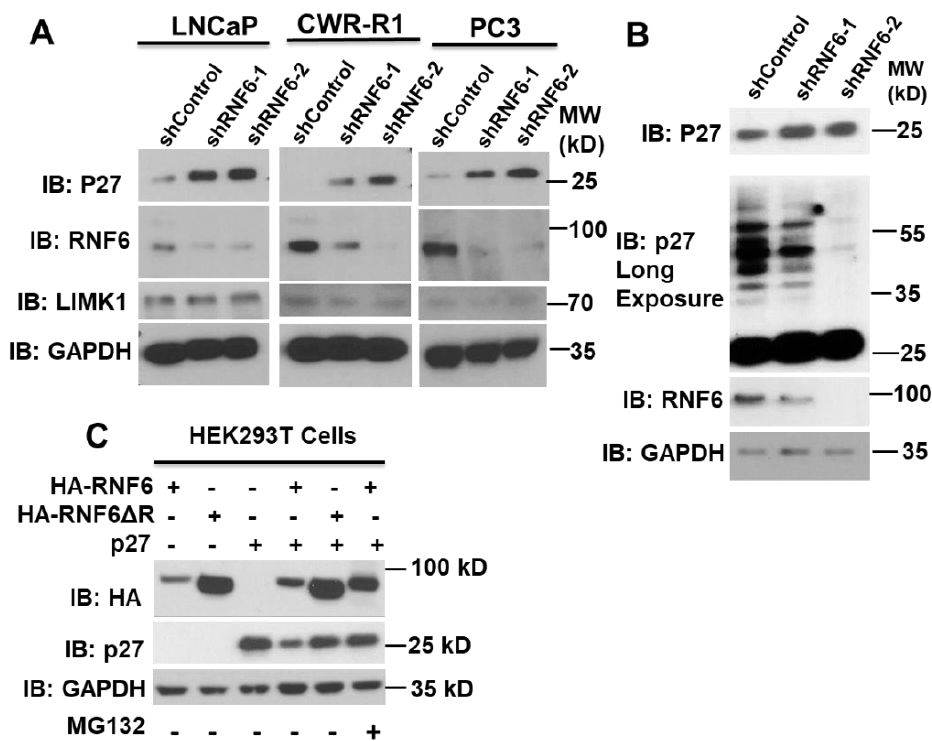
Figure 1. Knockdown of RNF6 leads to increase in stability of p27. ( A ) Prostate cancer cell lines were transduced with either control shRNA or shRNF6-1/2. After 72 h of knockdown, cells were lysed and lysates subjected to western blot analyses. ( B ) LNCaP cells were transduced with either control shRNA or shRNF6 1/2. After 72 h, cells were lysed and lysates subjected to Western blot analysis. ( C ) HEK293 cells were transfected with the indicated plasmids by the CaCl2 method. After 42 h, MG132 (10 µM) was added as shown. After 48 h of transfection, cells were lysed in RIPA buffer with protease inhibitors. The lysates were then subjected to western blot analysis.